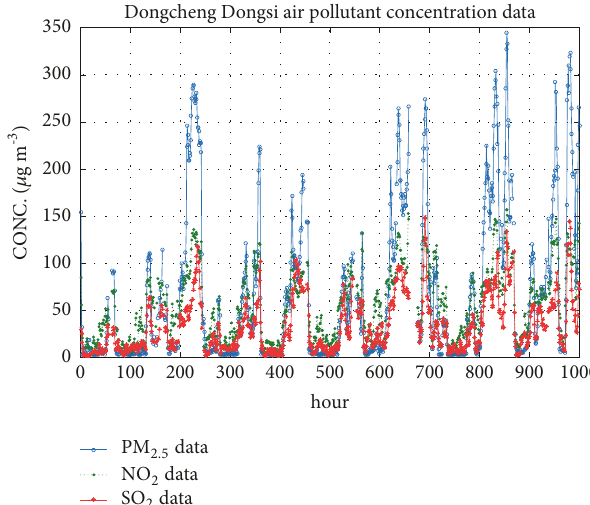
Figure 1: The observed data from 7 o’clock in November 30, 2014, to 22 o’clock in January 10, 2015. In the figure, time is measured along the horizontal axis and the concentrations of three kinds of airpollutants (PM 2.5 , NO 2 , and SO 2 ) are measured along the vertical axis. There are some missing values in data sets. Dongcheng Dongsi is a target air-quality-monitor-station selected in this